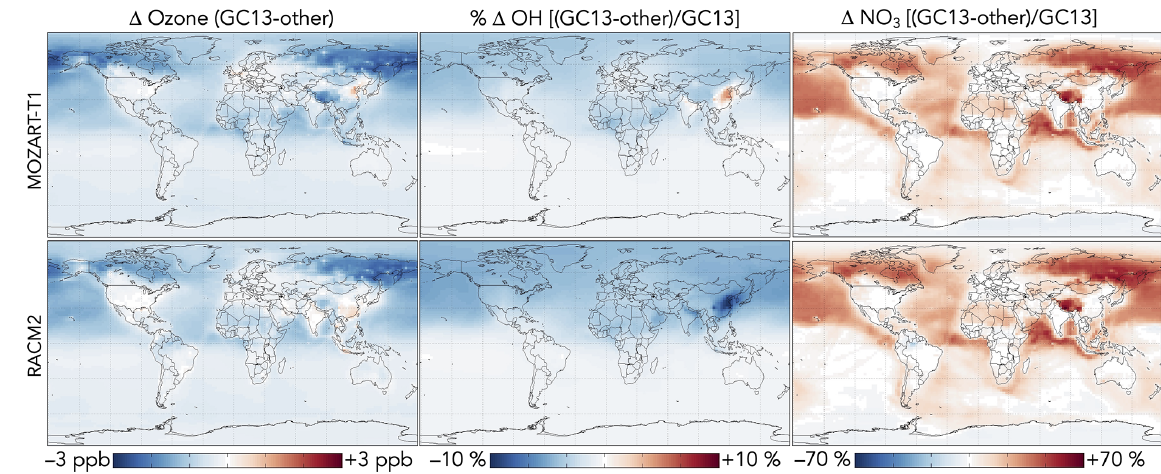
Figure 14. Differences in ozone, OH, and NO 3 concentrations between the GC13 mechanism and the MOZART-T1 and RACM2 mecha- nisms for aromatic chemistry. Values are absolute (for OH) or percent (for other species) differences in annual mean concentrations below 1km altitude between GEOS-Chem simulations with the GC13 mechanism and with the MOZART-T1 or RACM2 mechanism. The color scales are